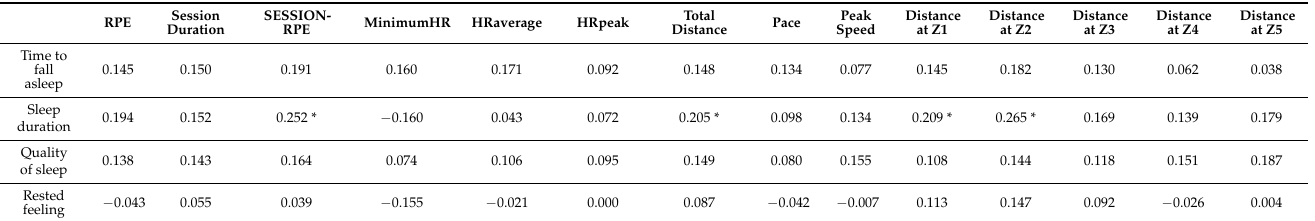
Table 4. Correlation coefficient (r) between sleep and training demands of the day after (sleep * training after sleep).